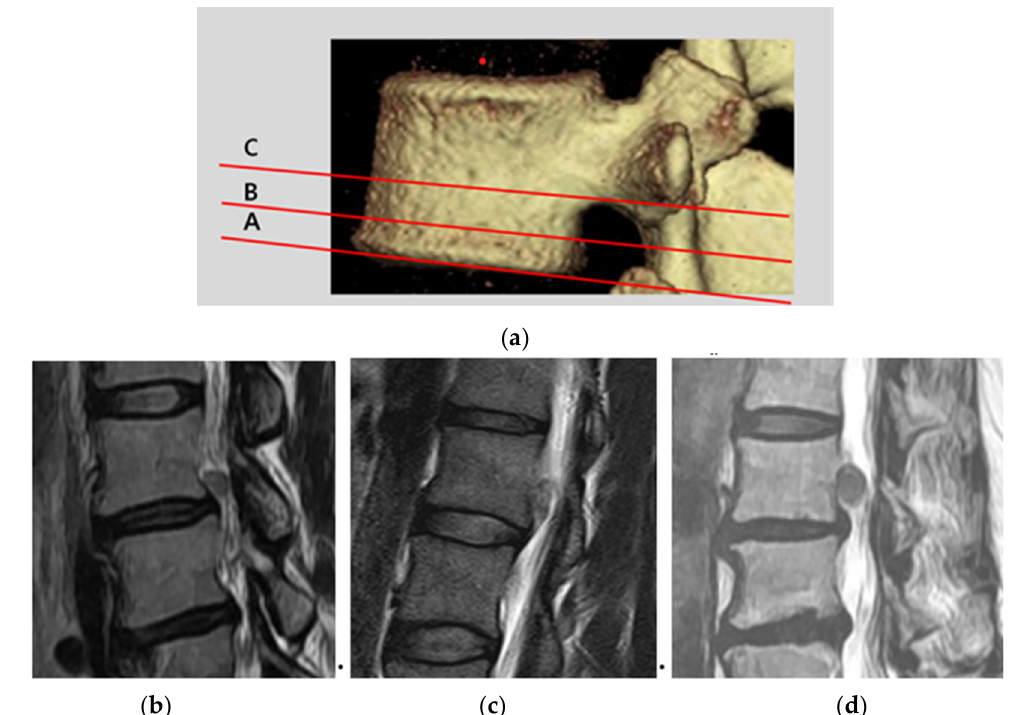
Figure 1. Classification of upward ruptured disc migration. ( a ) Type A, upward migration extent was less than half of the interval from the upper disc end plate line to the inferior pedicle margin; ( b ) type B, upward migration extent was more than half of the interval from the upper disc end plate line to the inferior pedicle margin; and ( c ) type C, upward migration extent was more than the lower margin of the pedicle ( d ).